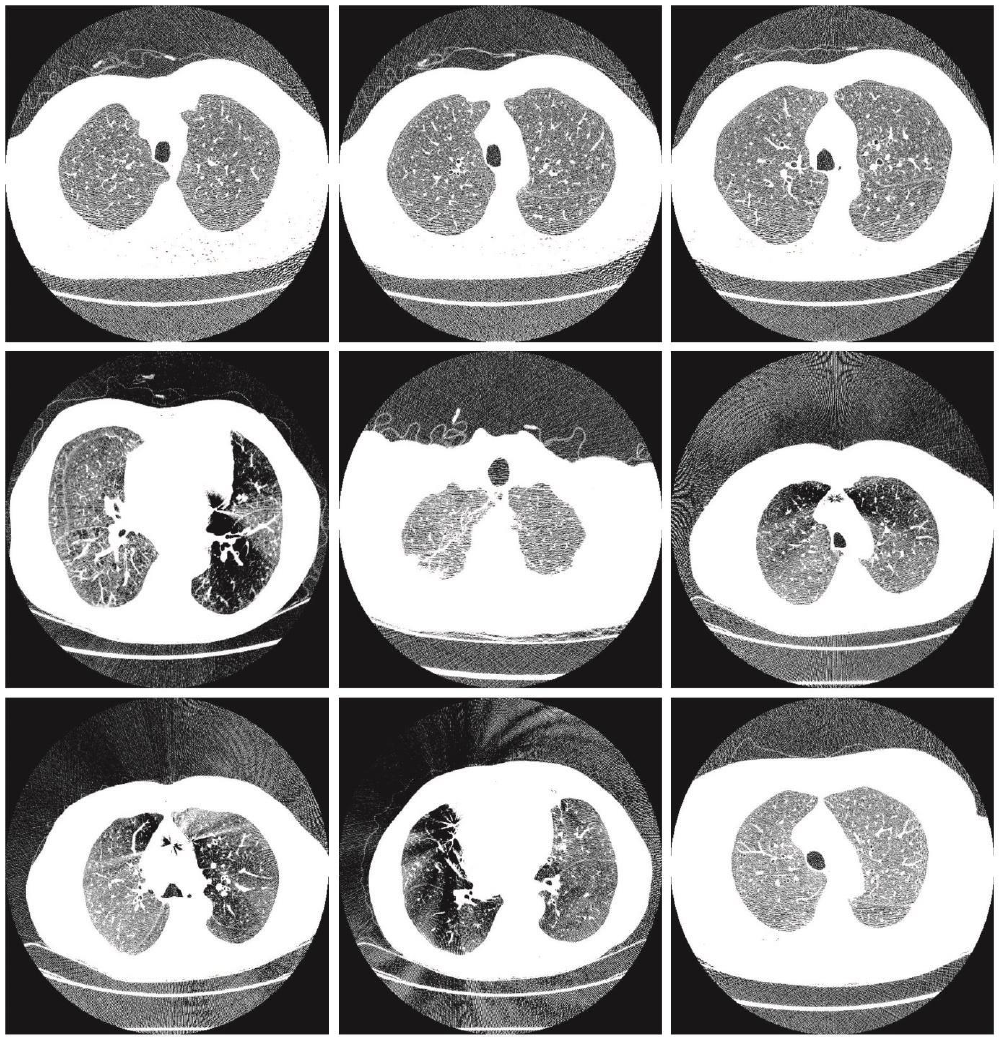
Figure 3. Sample Images.